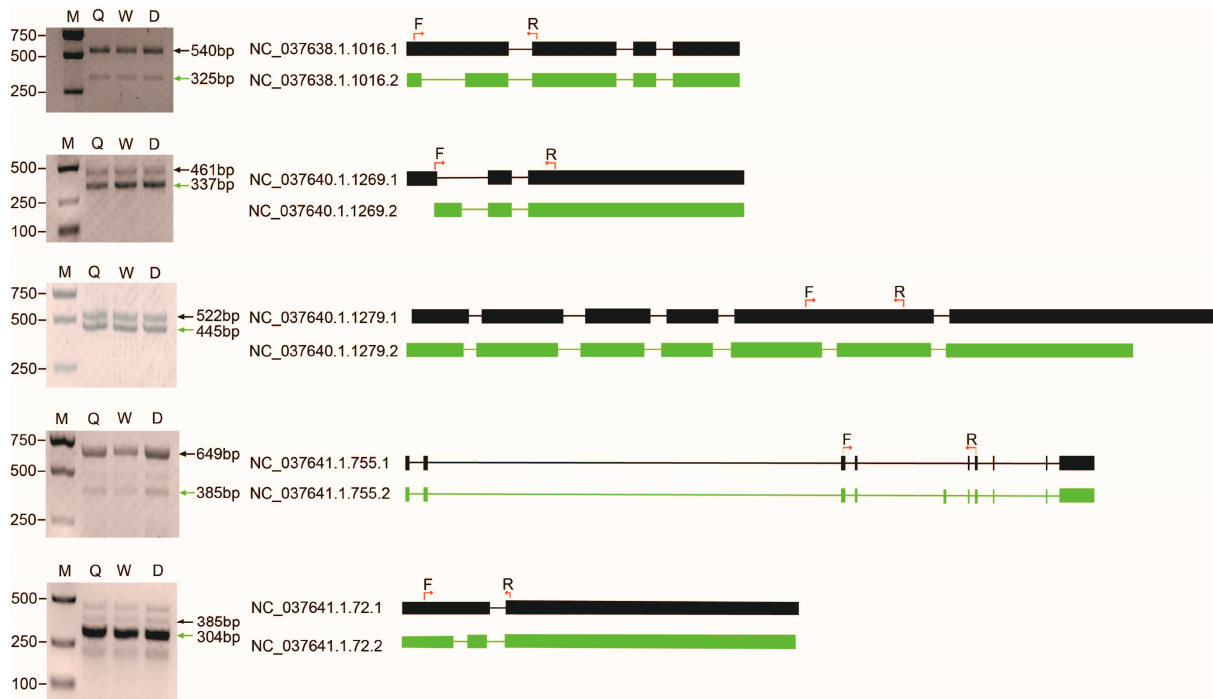
Figure 4. Verification of the alternative splicing events in five genes by RT-PCR and Sanger sequencing. The exon/intron structure of each isoform of each gene is shown in the right panel. The filled boxes represent exons and the lines represent introns. Different isoforms of each gene are displayed in green or black. The locations of the PCR primers are shown with red arrows on the first isoform of each gene. M: marker, Q: queen, W: worker, D: